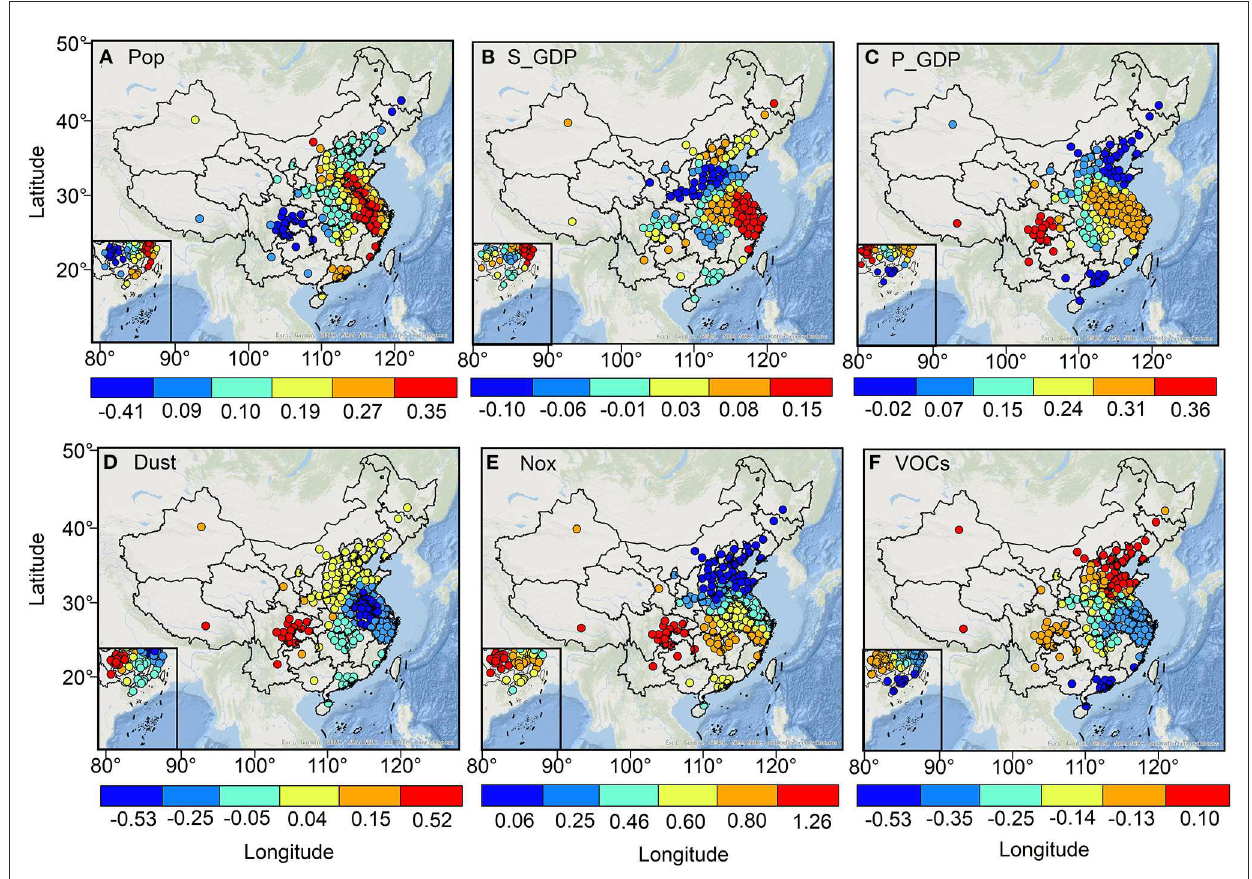
FIGURE9 The spatial distribution of regression coefficients for the major socioeconomic factors of Pop (A) , S_GDP (B) , P_GDP (C) , Dust (D) , NOx (E) , and VOCs (F)